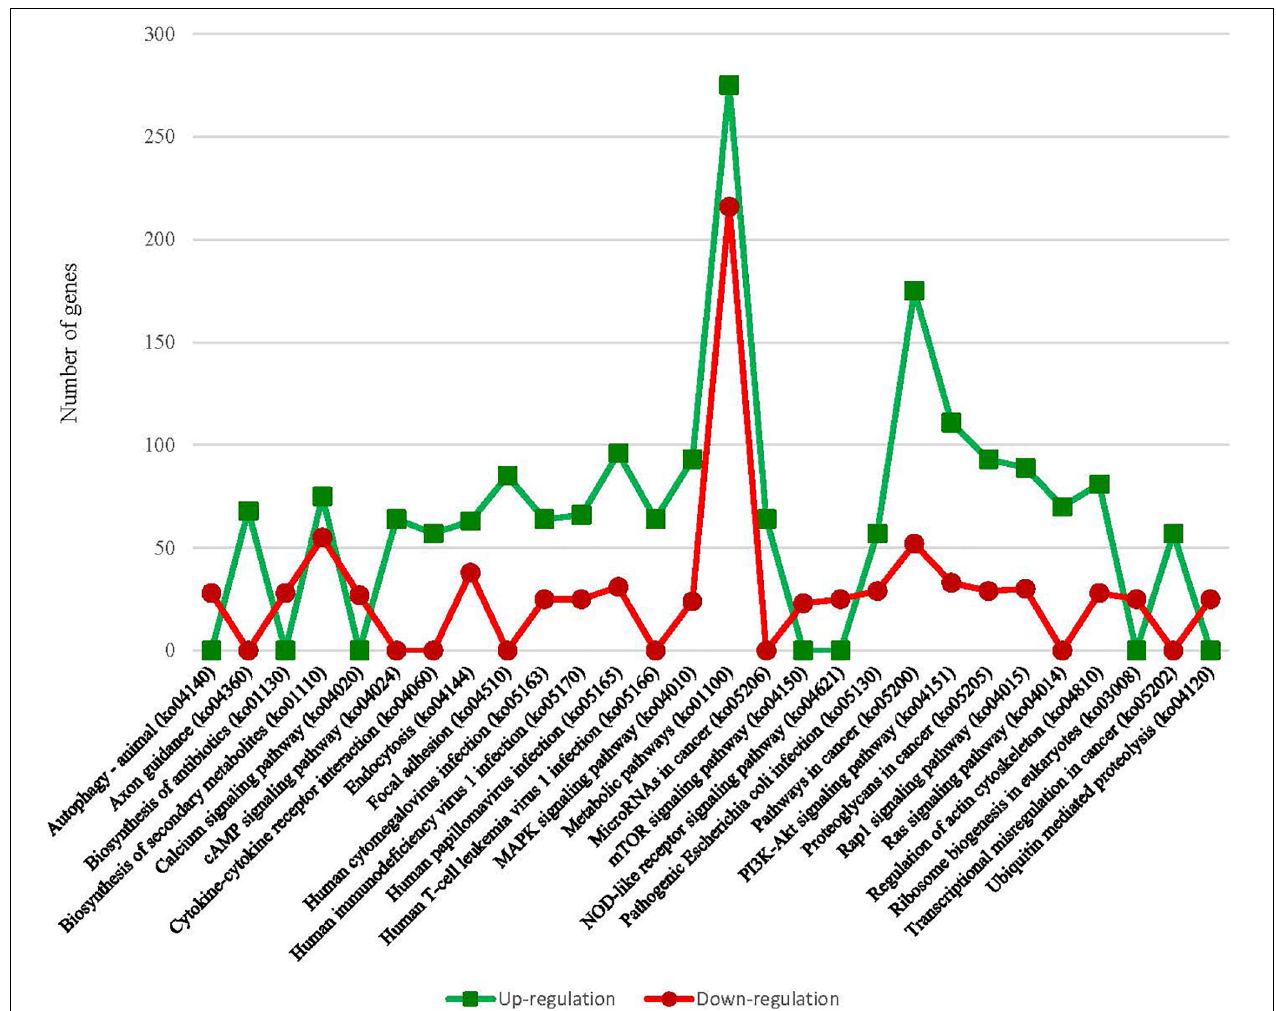
FIGURE 3 | Comparison of the top 20 KEGG pathways with the highest representation of DEGs between A. baenschi albino-type and